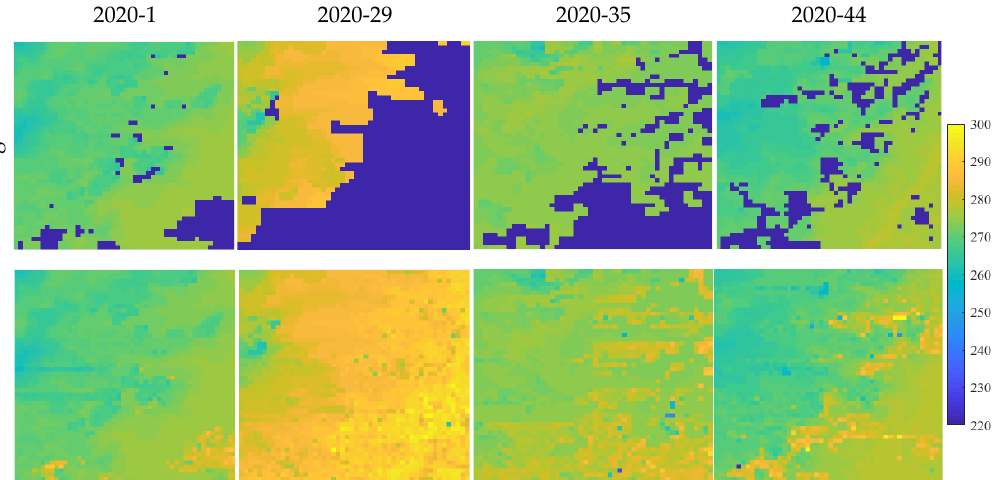
Figure 10. Comparison of the effect before and after reconstruction in the small area of Wenchuan, Sichuan province. The dark blue in the original image shows the missing areas.